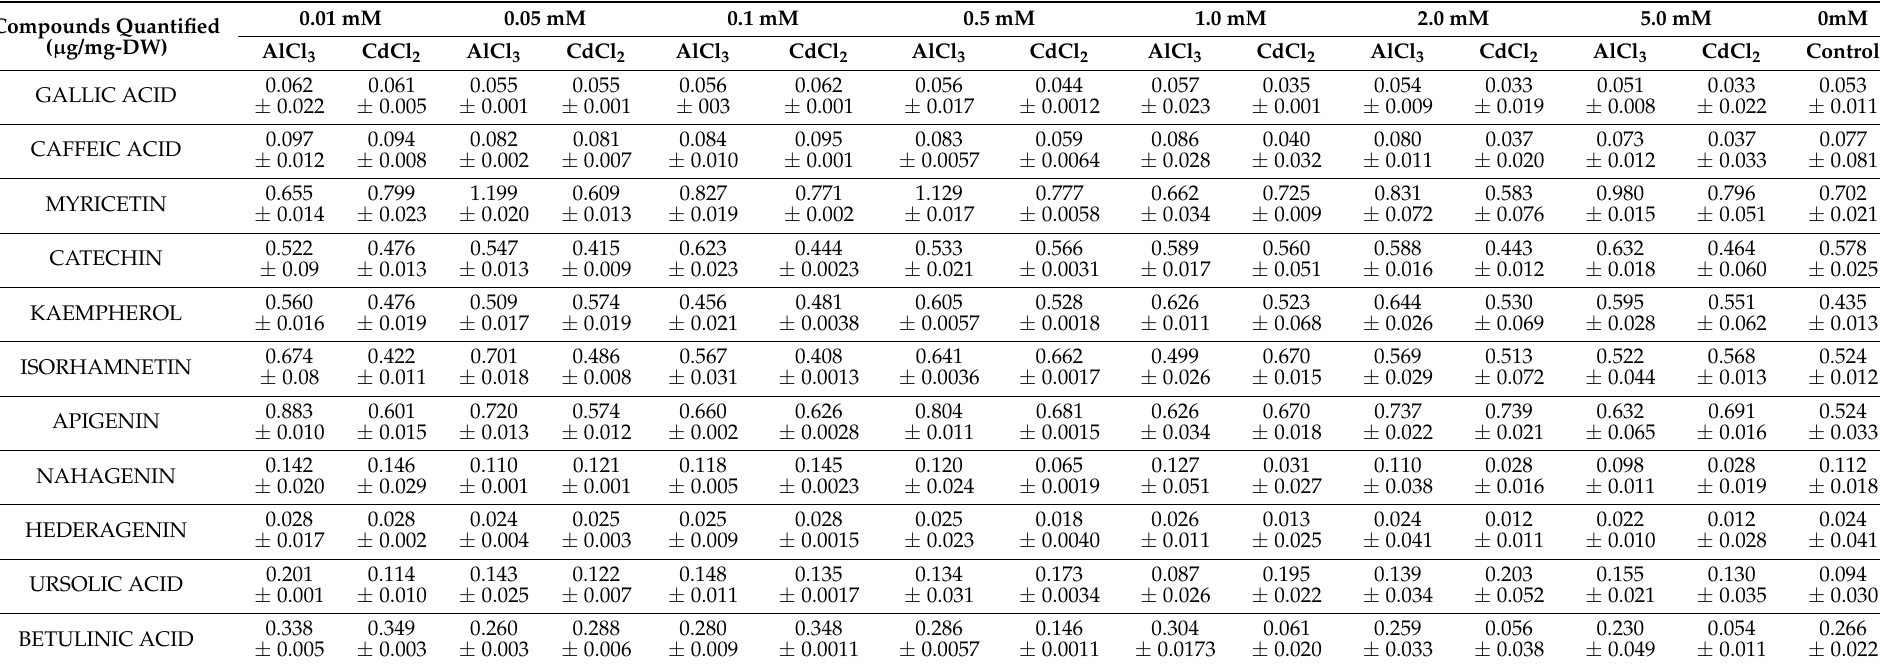
Table A1. HPLC-based quantification of pharmacologically important phenolic compounds in F. indica